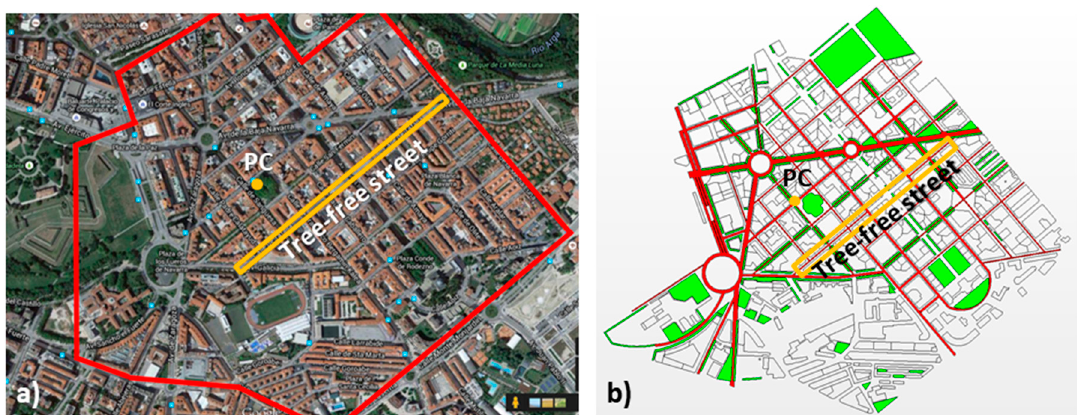
Figure 1. ( a ) Modeled area of the Pamplona neighborhood, with indication of the traffic air quality monitoring station called Plaza de la Cruz (PC) and the study tree-free street (Tafalla Street) where the ventilation is evaluated. ( b ) A sketch of the area of interest including emissions (red) and trees (green).